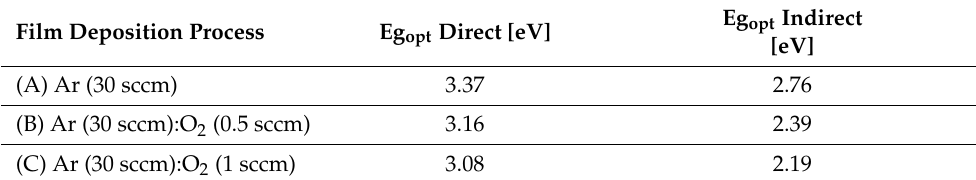
Table 1. The optical band gap Eg opt of the films.